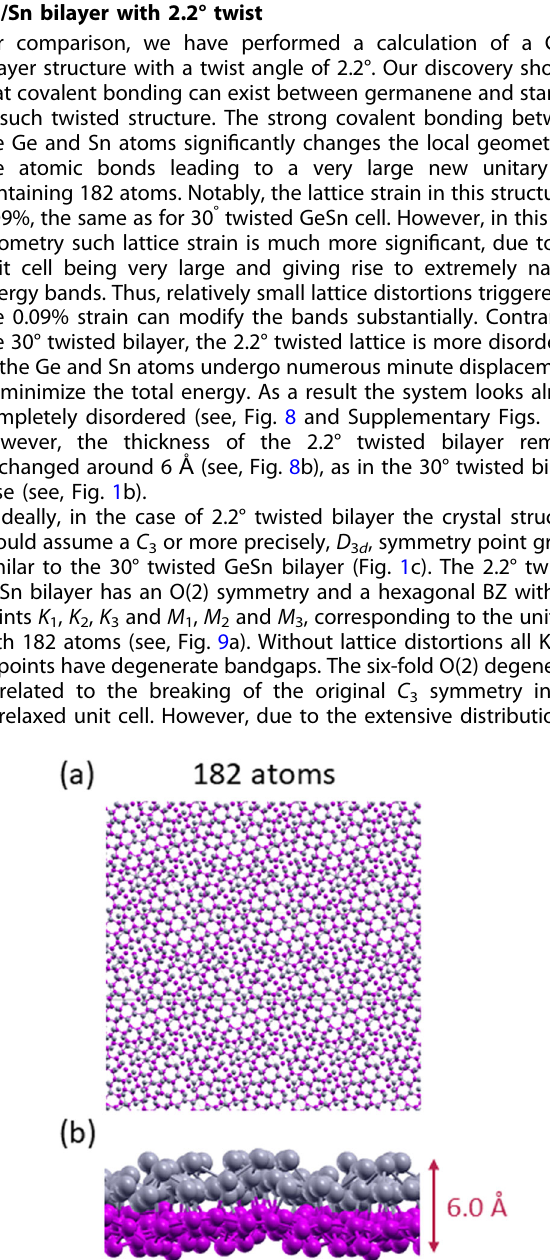
Fig. 8 Equilibrium geometry of the 2.2° twist-angle GeSn bilayer. a Top view of the unitary cell containing 182 atoms. The lattice strain is 0.09%. All atoms experience lattice distortions both in the xy - plane and in the z direction. b Side view showing signi fi cant lattice distortions in the vertical z direction. The thickness of this type of bilayer is around 6 Å , same as for the 30° twist-angle